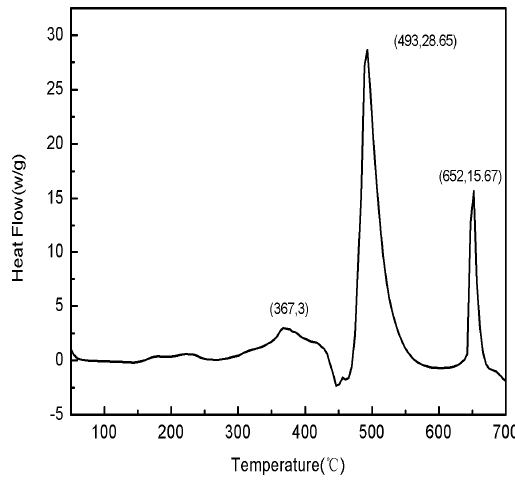
Figure 8. The TG curve of Sample 0 HTPB fuel.